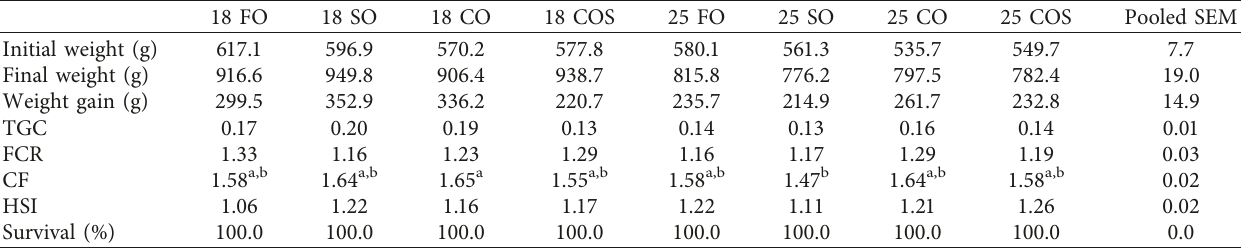
Table 6: Effect of feeding with a washout diet of herring oil on rainbow trout growth, nutritive utilization, and somatic parameters. 18 FO 18